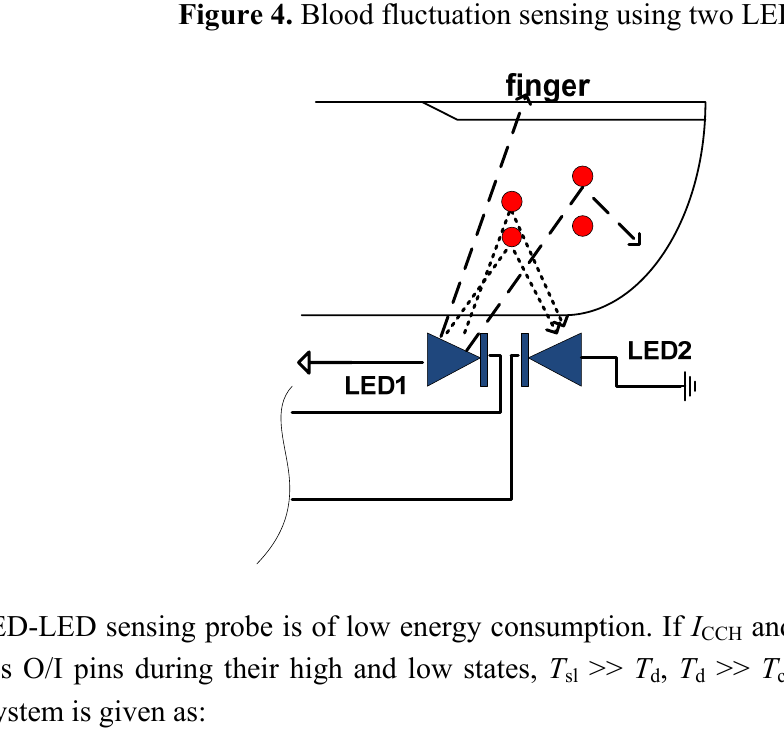
Figure 4. Blood fluctuation sensing using two